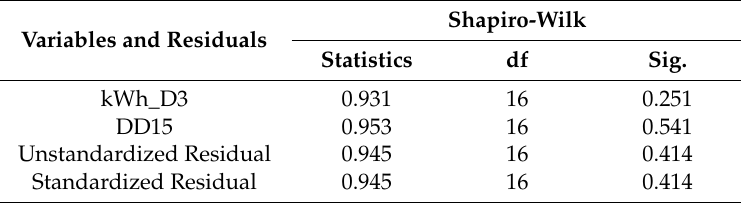
Table 4. Compliance with normality assumption (Shapiro-Wilk).